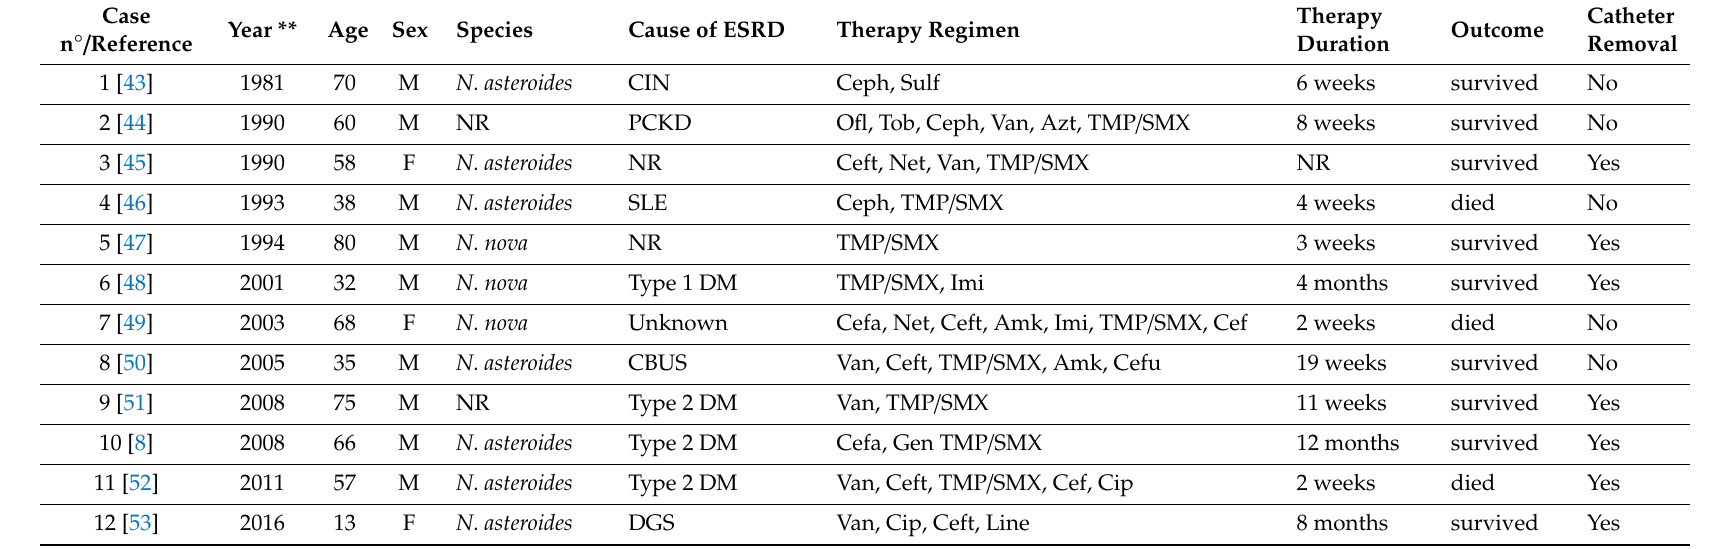
Table 4. Nocardia peritonitis in patients with continuous ambulatory peritoneal dialysis